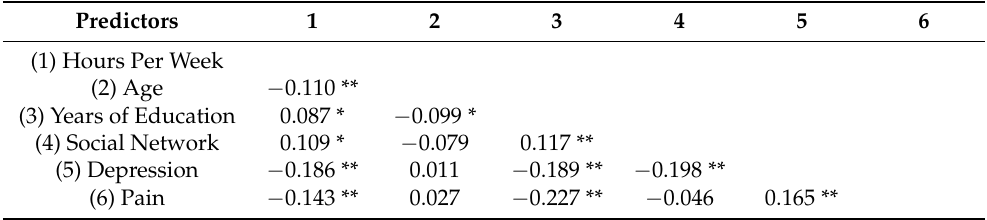
Table 5. Correlation of Retained Predictors and METs Per Week.